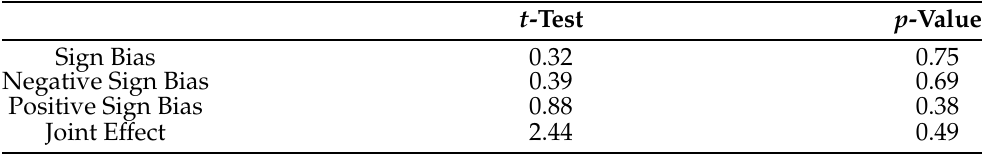
Table A3. t -test values of the sign bias test for standardized residuals when assuming SGED.